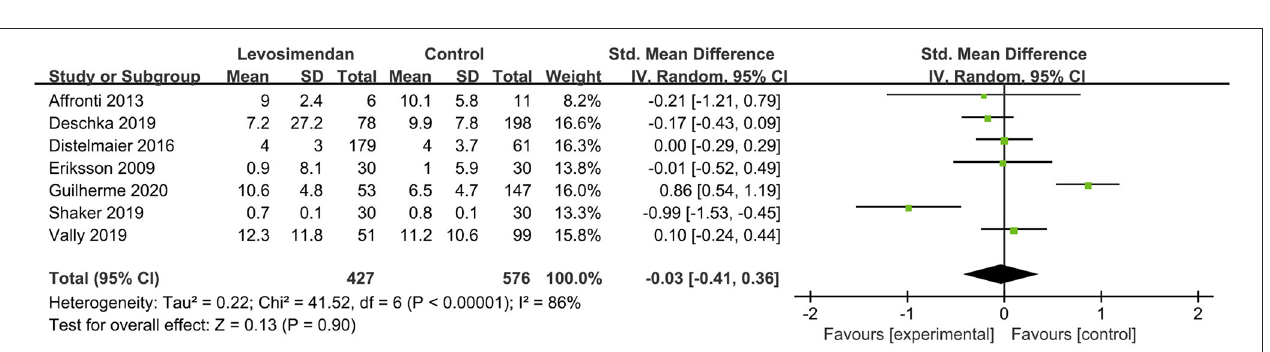
FIGURE 3 | Forest plots of the effects of levosimendan therapy on duration of mechanical ventilation.